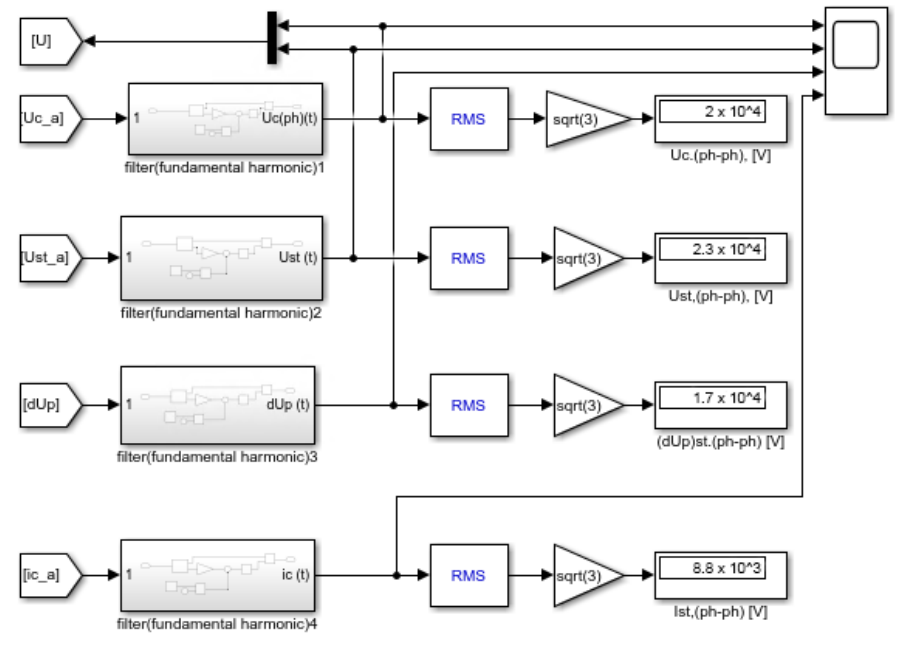
Figure 6. Measurement block.